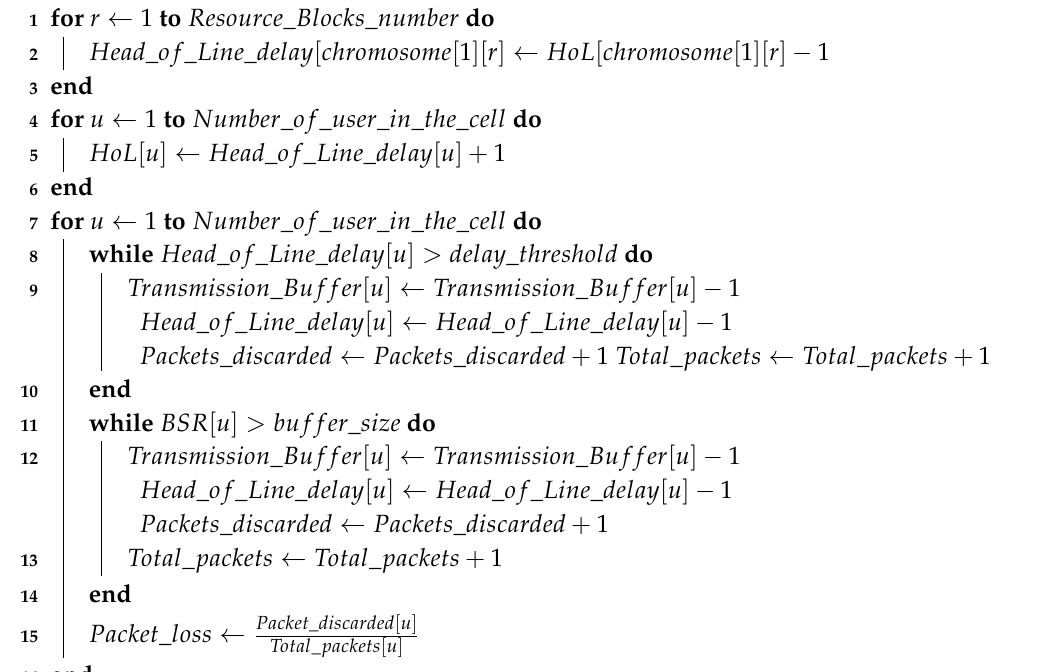
Algorithm 4: Buffers and HoL